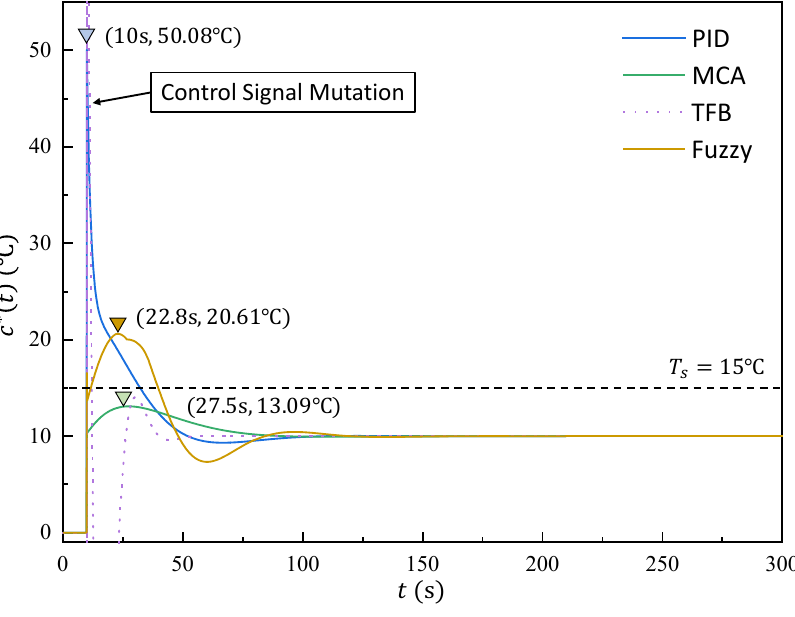
𝑡𝑡 (s) Figure 8. PID controller output signal.